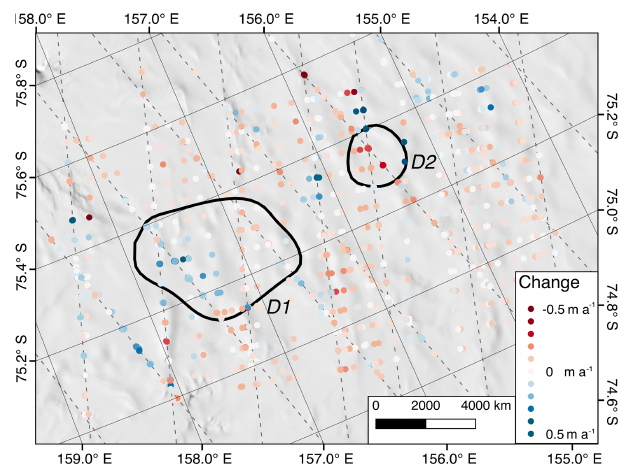
Figure 6. Difference between the 2017 KOPRI surface elevations and the 2004–2009 ICESat elevations, normalized by time between observations. Blue is rising; red is falling. Dashed lines are nom- inal ICESat ground tracks. The background image is the MODIS